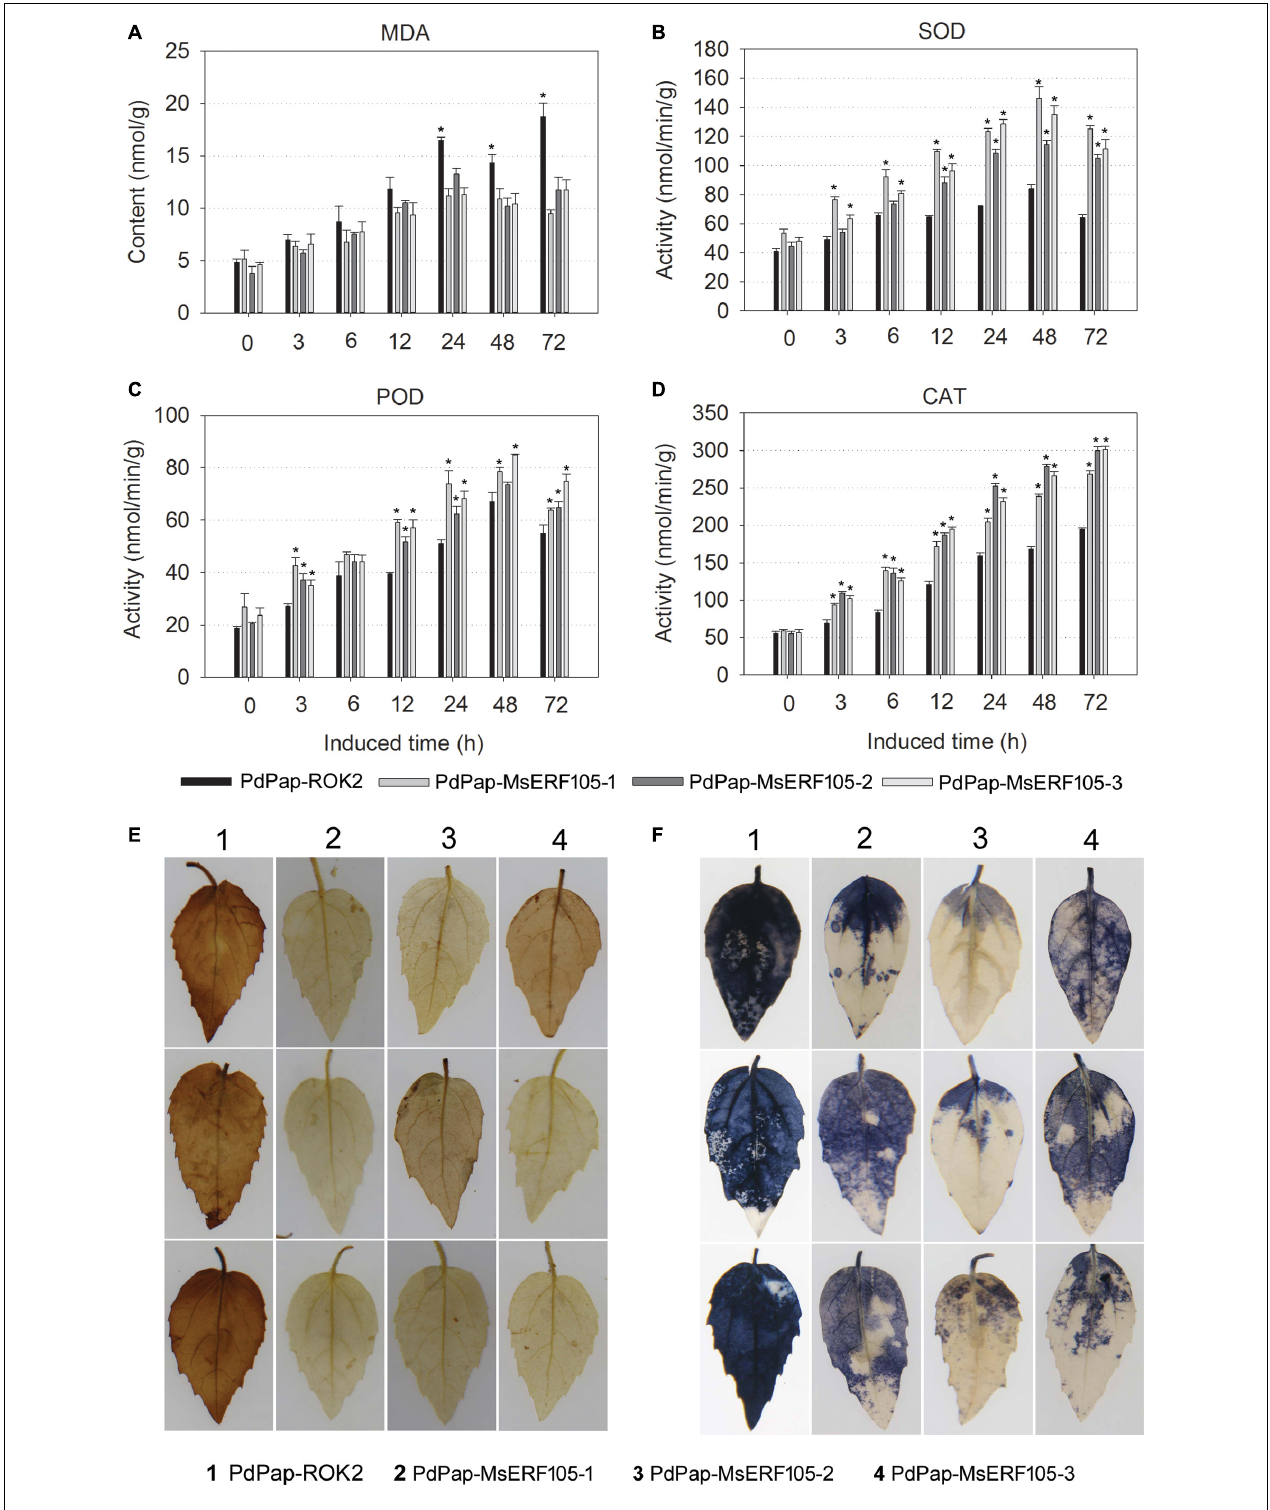
FIGURE 5 | Antioxidant ability of PdPap-MsERF105. (A) The MDA content. (B) The SOD activity. (C) The POD activity. (D) The CAT activity. (E) DAB staining of PdPap leaves. (F) NBT staining of PdPap leaves. ANOVA was conducted using Duncan’s method, and p ≤ 0.05 was considered significant. CAT: catalase, DAB: diaminobenzidine, MDA: malondialdehyde, NBT: nitrotetrazolium blue chloride, POD: peroxidase, SOD: superoxide dismutase.